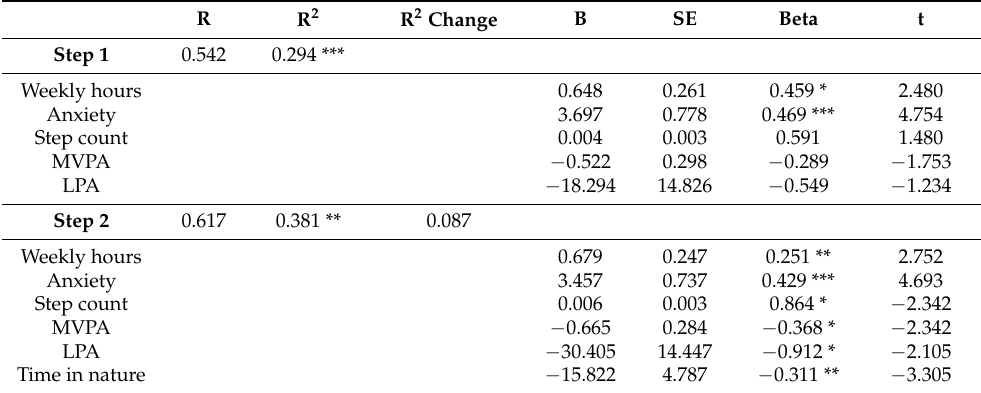
Table 3. Hierarchical multiple regression model of chronic fatigue. Time in nature is a significant predictor of chronic fatigue after controlling for anxiety.